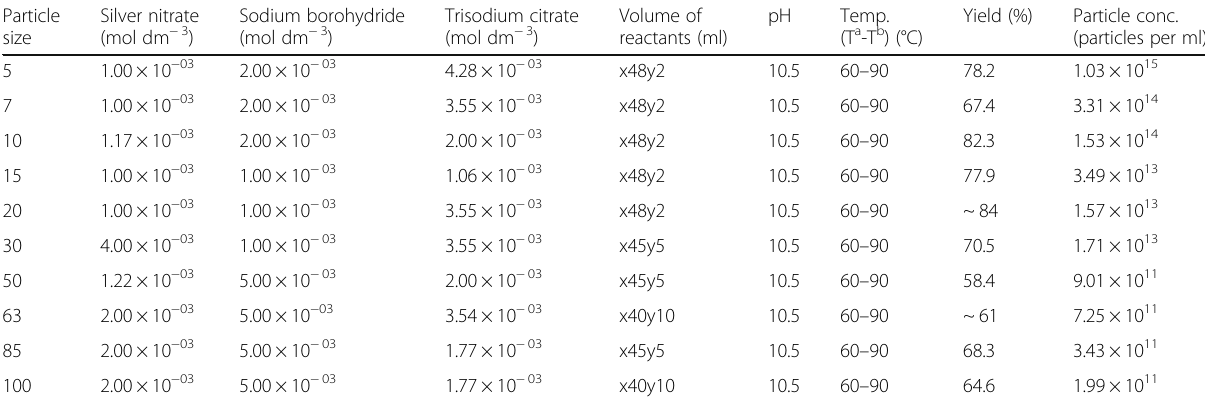
Table 1 Designed Conditions for the Synthesis of Different-Sized Silver Nanoparticles a [60] Particle